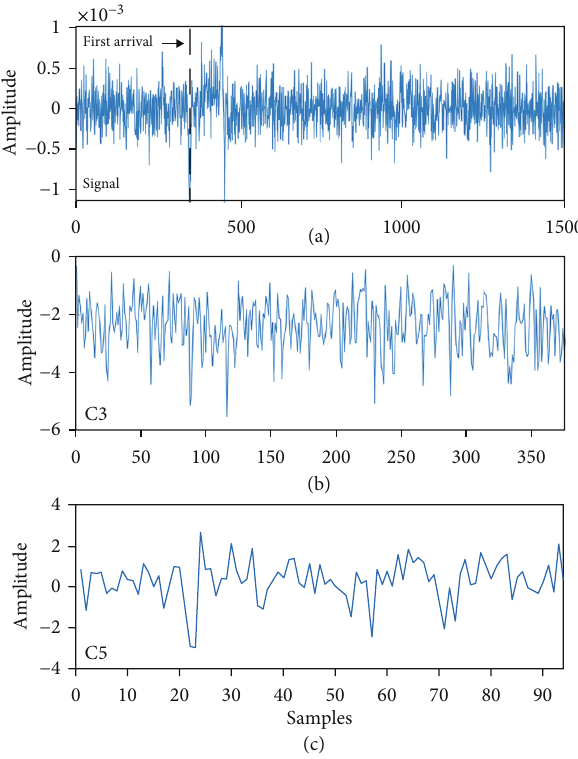
Figure 15: Forward modeling signal with -8-dB Gaussian noise added and its intermediate features extracted by the UNet++. (a) The forward modeling signal with -8-dB Gaussian noise added. (b) Intermediate features of the signal extracted by C3 layer. (c) Intermediate features of the signal extracted by C5 layer.